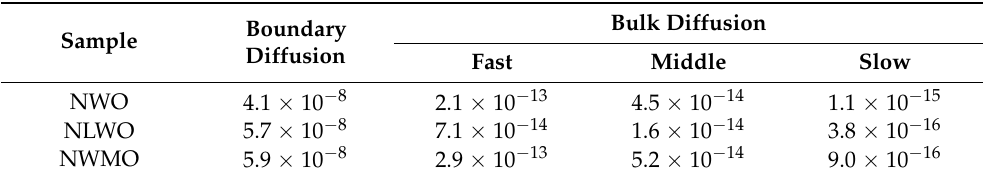
Table 4. Oxygen tracer diffusion coefficient values ( D * (cm 2 s − 1 )) at 500 ◦ C for (Nd,La) 5.5 (W,Mo)O 11.25 − δ samples sintered by RTS according to TPIE with C 18 O 2